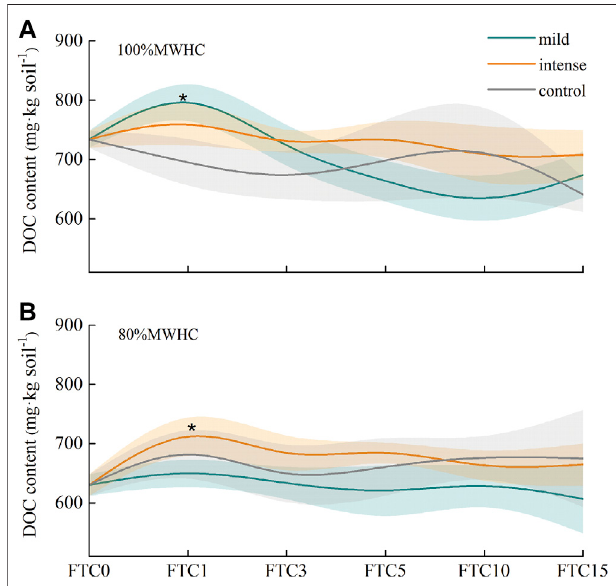
FIGURE4| DOCcontentinfreeze – thawcycles. (A) TheDOCoutputsof 100%MWHC peat; (B) the DOC outputs of 80%MWHC peat. Mild means freeze – thaw cycleat − 5~4 ° C;intensemeans freeze – thawcycle at − 15 – 4 ° C;*, thereisasigni fi cantdifferencebetweenthefreeze – thawpeatandcontrol group ( p <